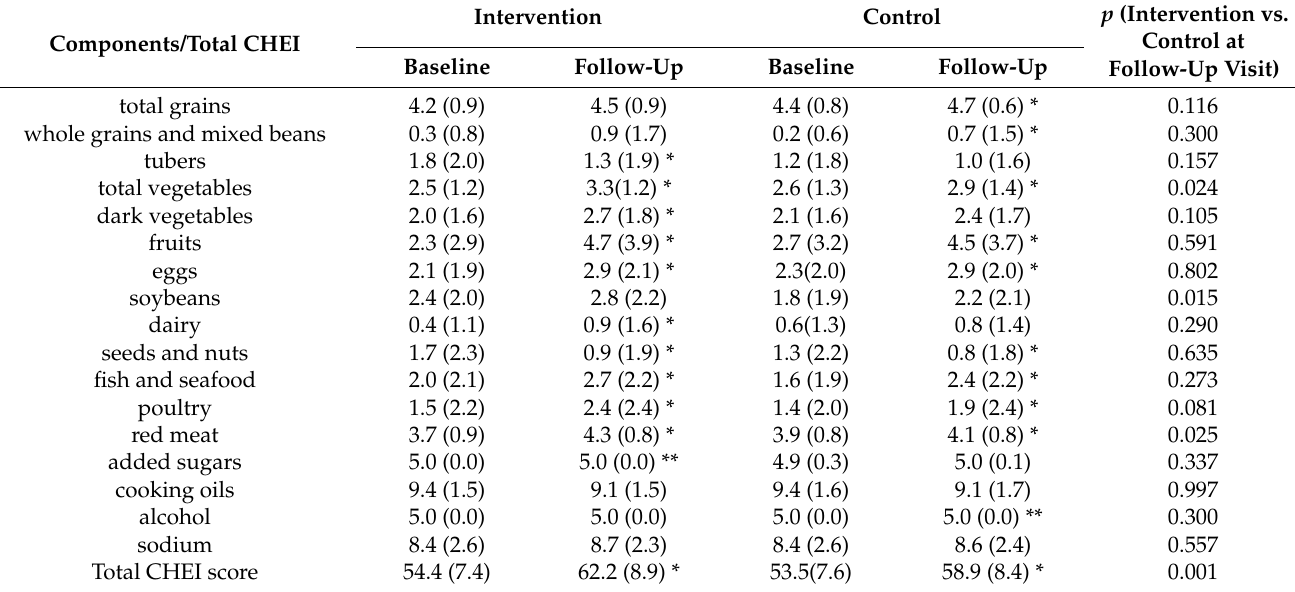
Table 2. Change of CHEI score in the intervention group and control group.